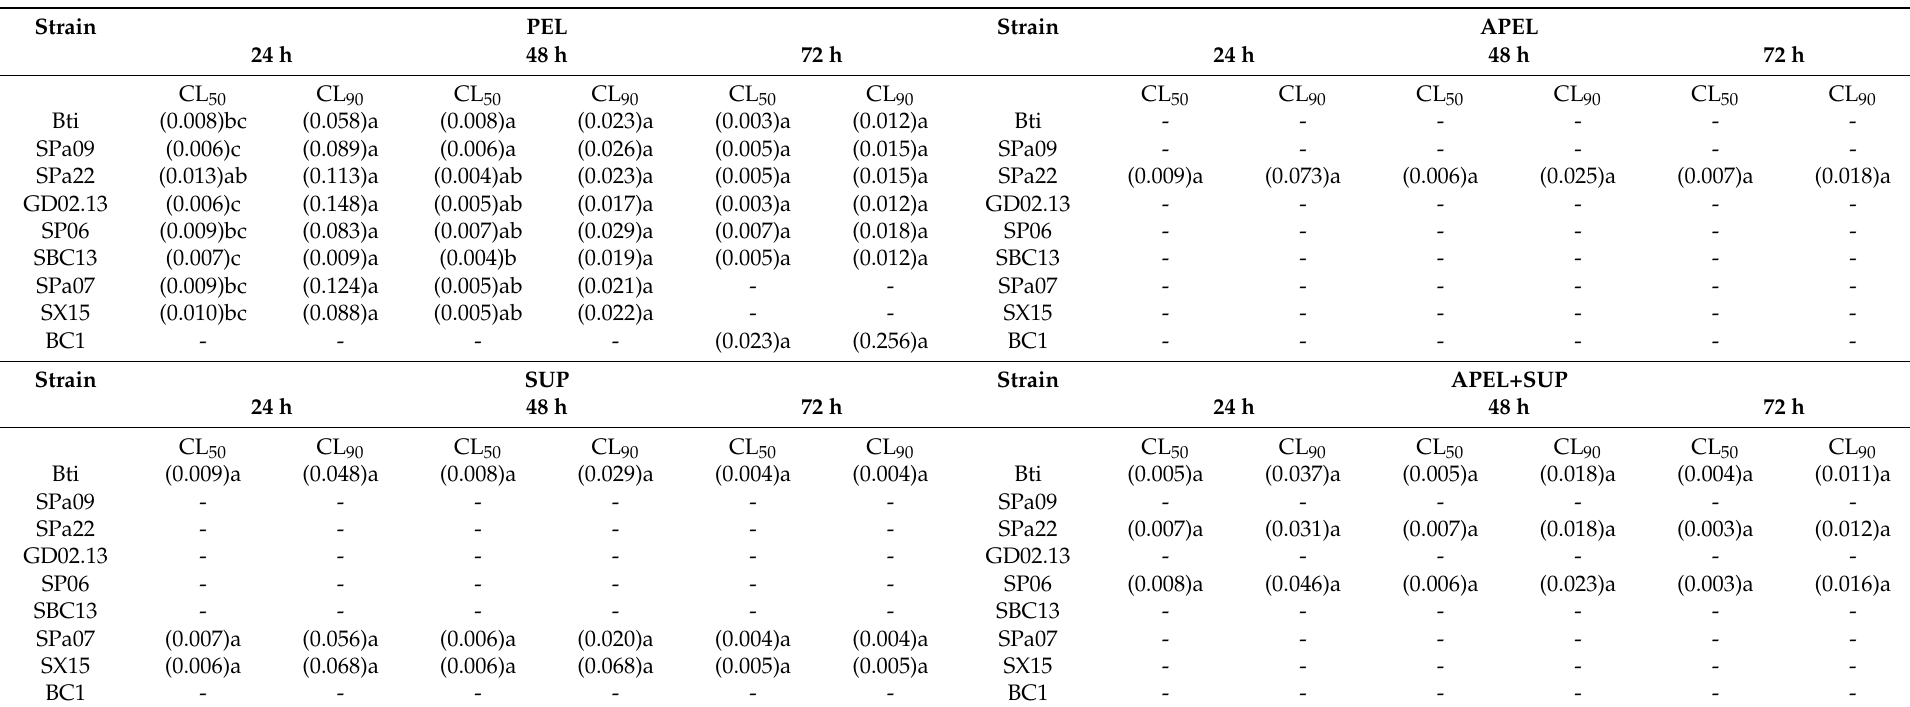
Table 3. LC 50 and LC 90 values of microbial culture fractions against A. aegypti